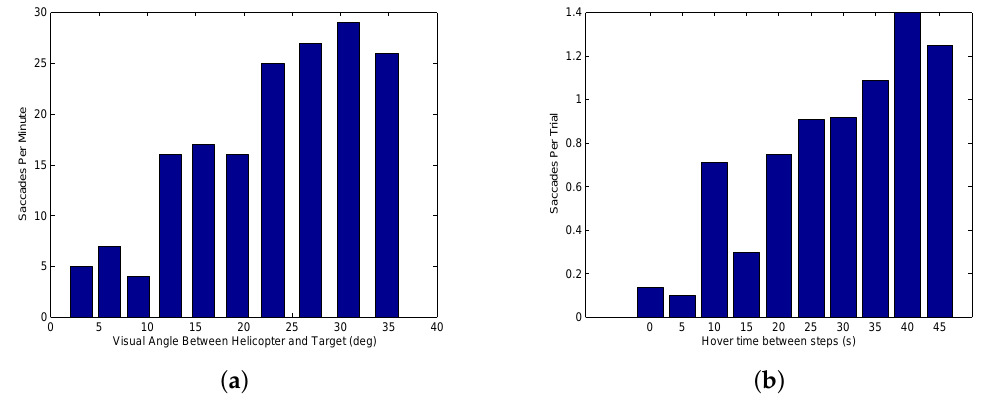
Figure 17. Saccade trigger factors. ( a ) The saccade frequency during hover experiments for different heights (visual angle between the helicopter and target on the ground). ( b ) The saccade frequency during step experiments for different lengths of hover time over the starting position (gives increasing lengths of time since the target location was last observed as part of the task